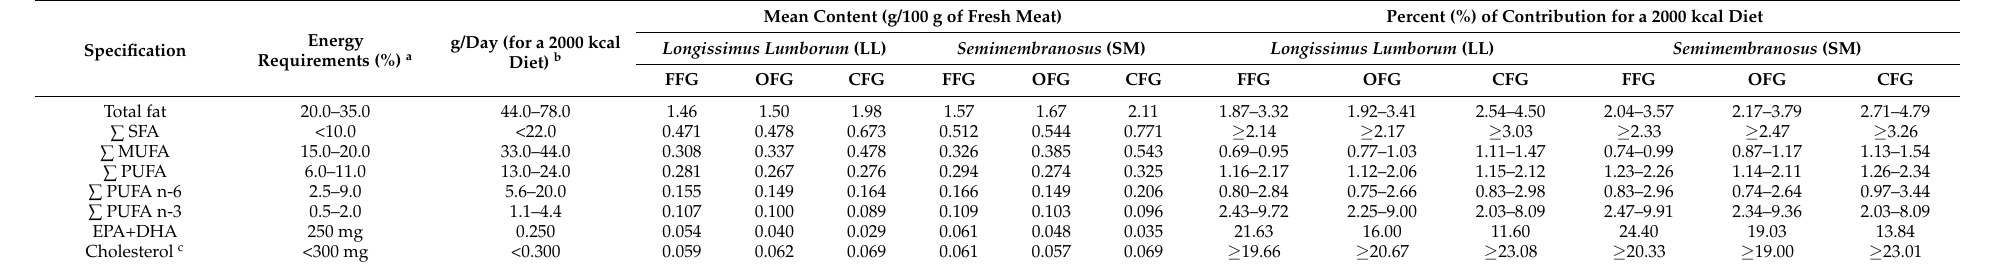
Table 5. Contribution of fat, fatty acids, and cholesterol to an adult diet provided by a 100-g portion of red deer meat sampled from the three feeding